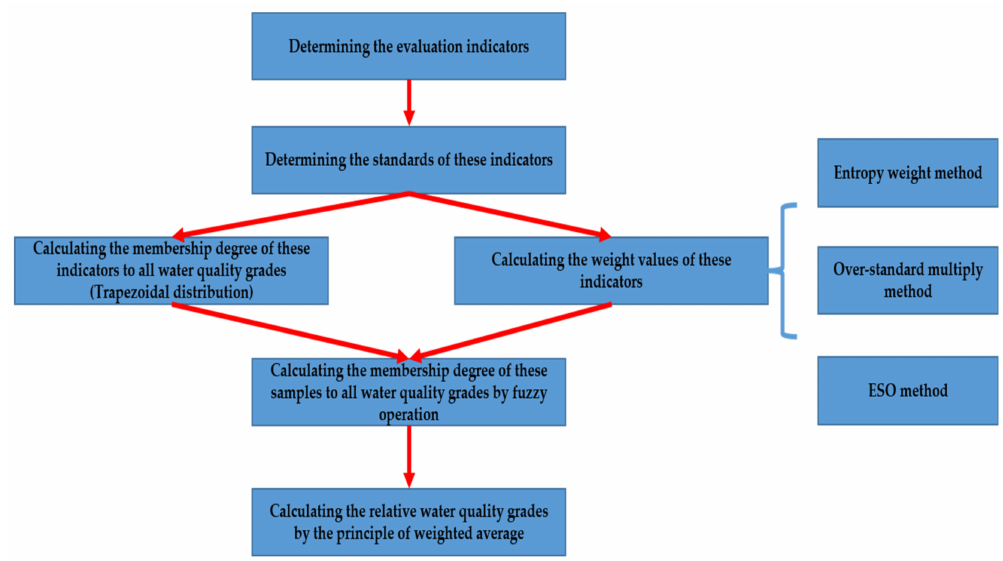
Figure 2. Technical roadmap of fuzzy synthetic evaluation